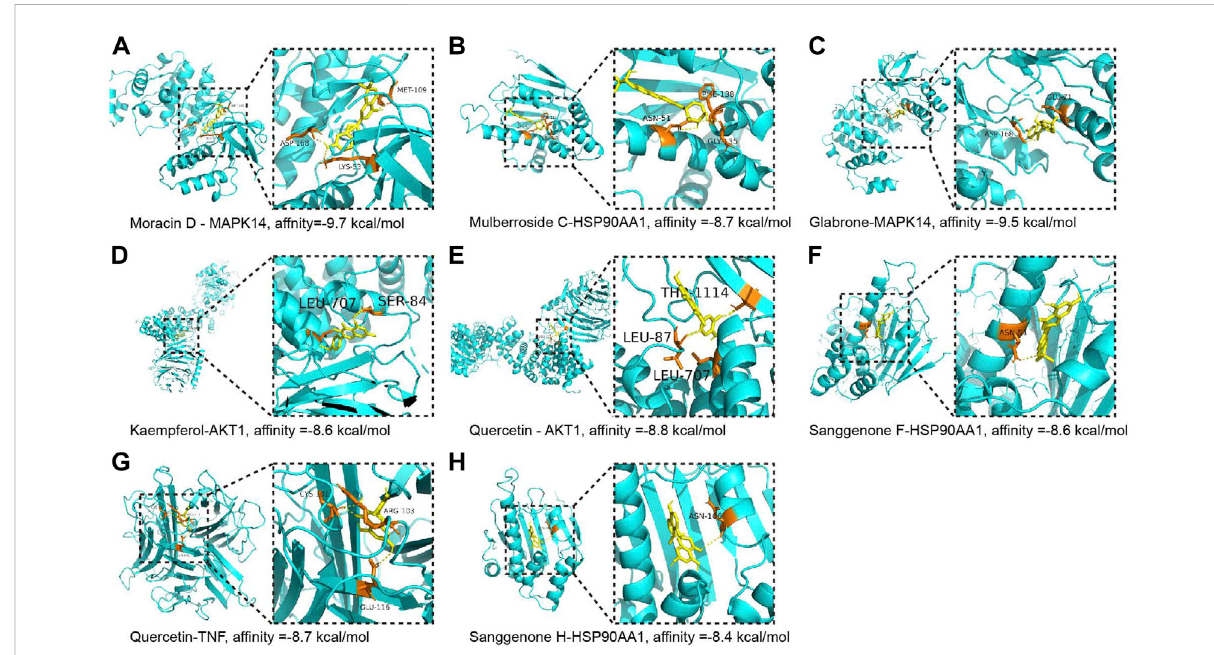
FIGURE 4 The molecular docking between the hub targets and bioactive compounds. (A) The 3D map of the binding of Moracin D and MAPK14, af fi nity = − 9.7 kcal/mol; (B) The 3D map of the binding of Mulberroside C and HSP90AA1, af fi nity = − 8.7 kcal/mol; (C) The 3D map of the binding of Glabrone and MAPK14, af fi nity = − 9.5 kcal/mol; (D) The 3D map of the binding of kaempferol and AKT1, af fi nity = − 8.6 kcal/mol; (E) The 3D map of thebinding ofquercetin and AKT1, af fi nity = − 8.8 kcal/mol; (F) The 3Dmap of the binding of SanggenoneF and HSP90AA1,af fi nity = − 8.6 kcal/ mol; (G) The 3D map of the binding of quercetin and TNF, af fi nity = − 8.7 kcal/mol; (H) The 3D map of the binding of Sanggenone H and HSP90AA1, af fi nity = − 8.4